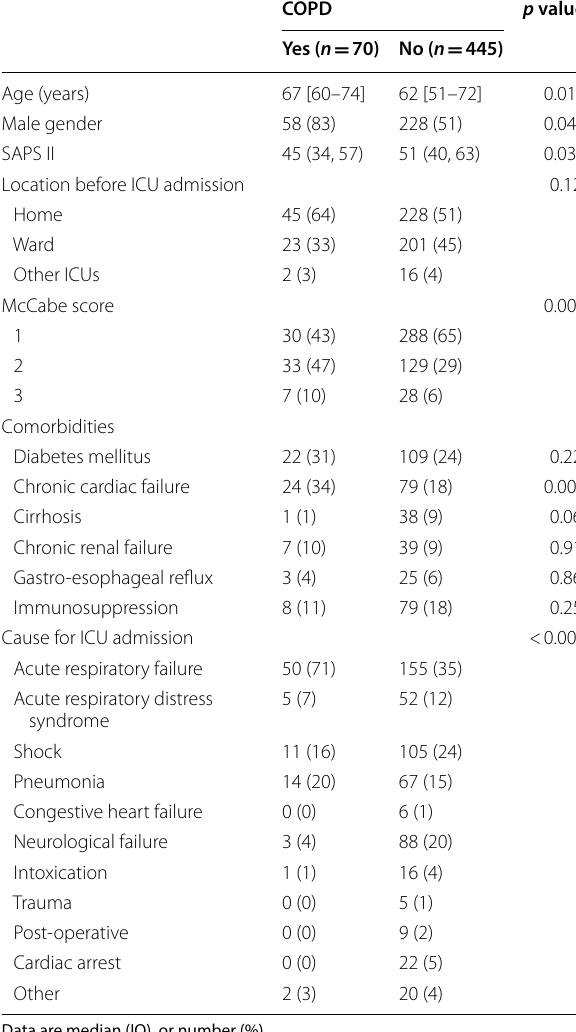
Table 1 Patient characteristics at ICU